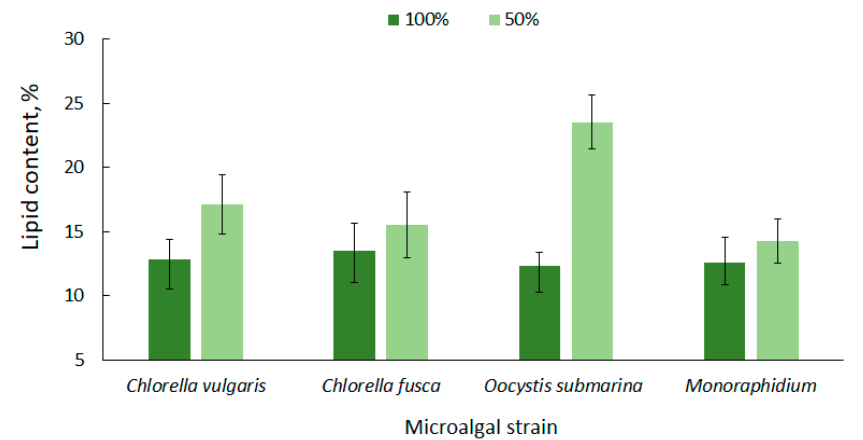
Figure 2. Lipid content in microalgal biomass under nutrient limitation.